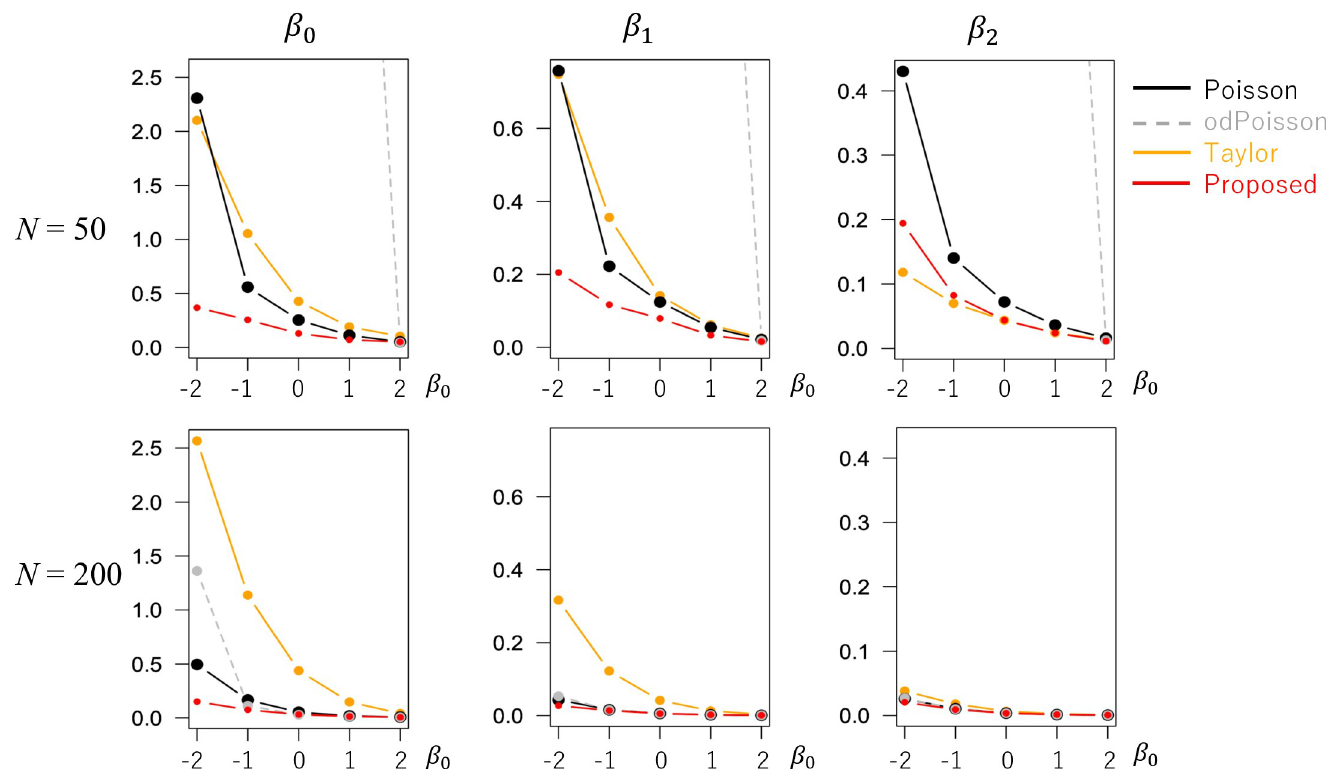
Fig 7. RMSE of the regression coefficients (model with spatial effects) (x-axis: β 0 , y-axis: RMSE).